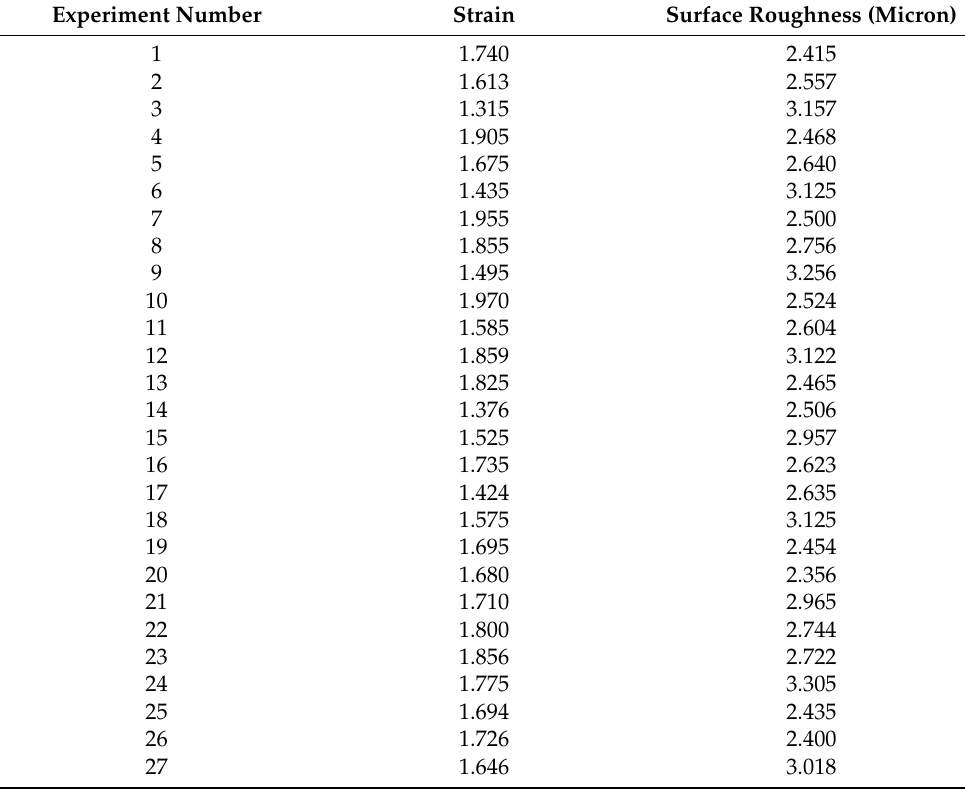
Figure 3. Deformed sheet during ISF process. Table 4. Reponses measured from the experiments .